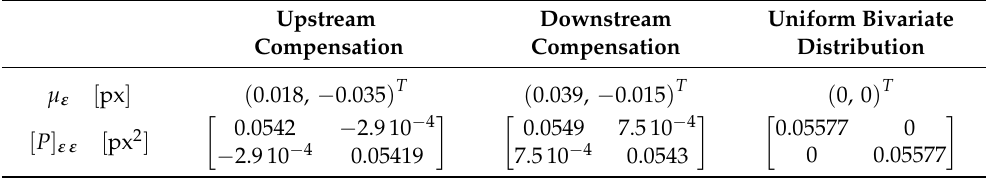
Table 2. Mean and covariance of the pixel error ε =